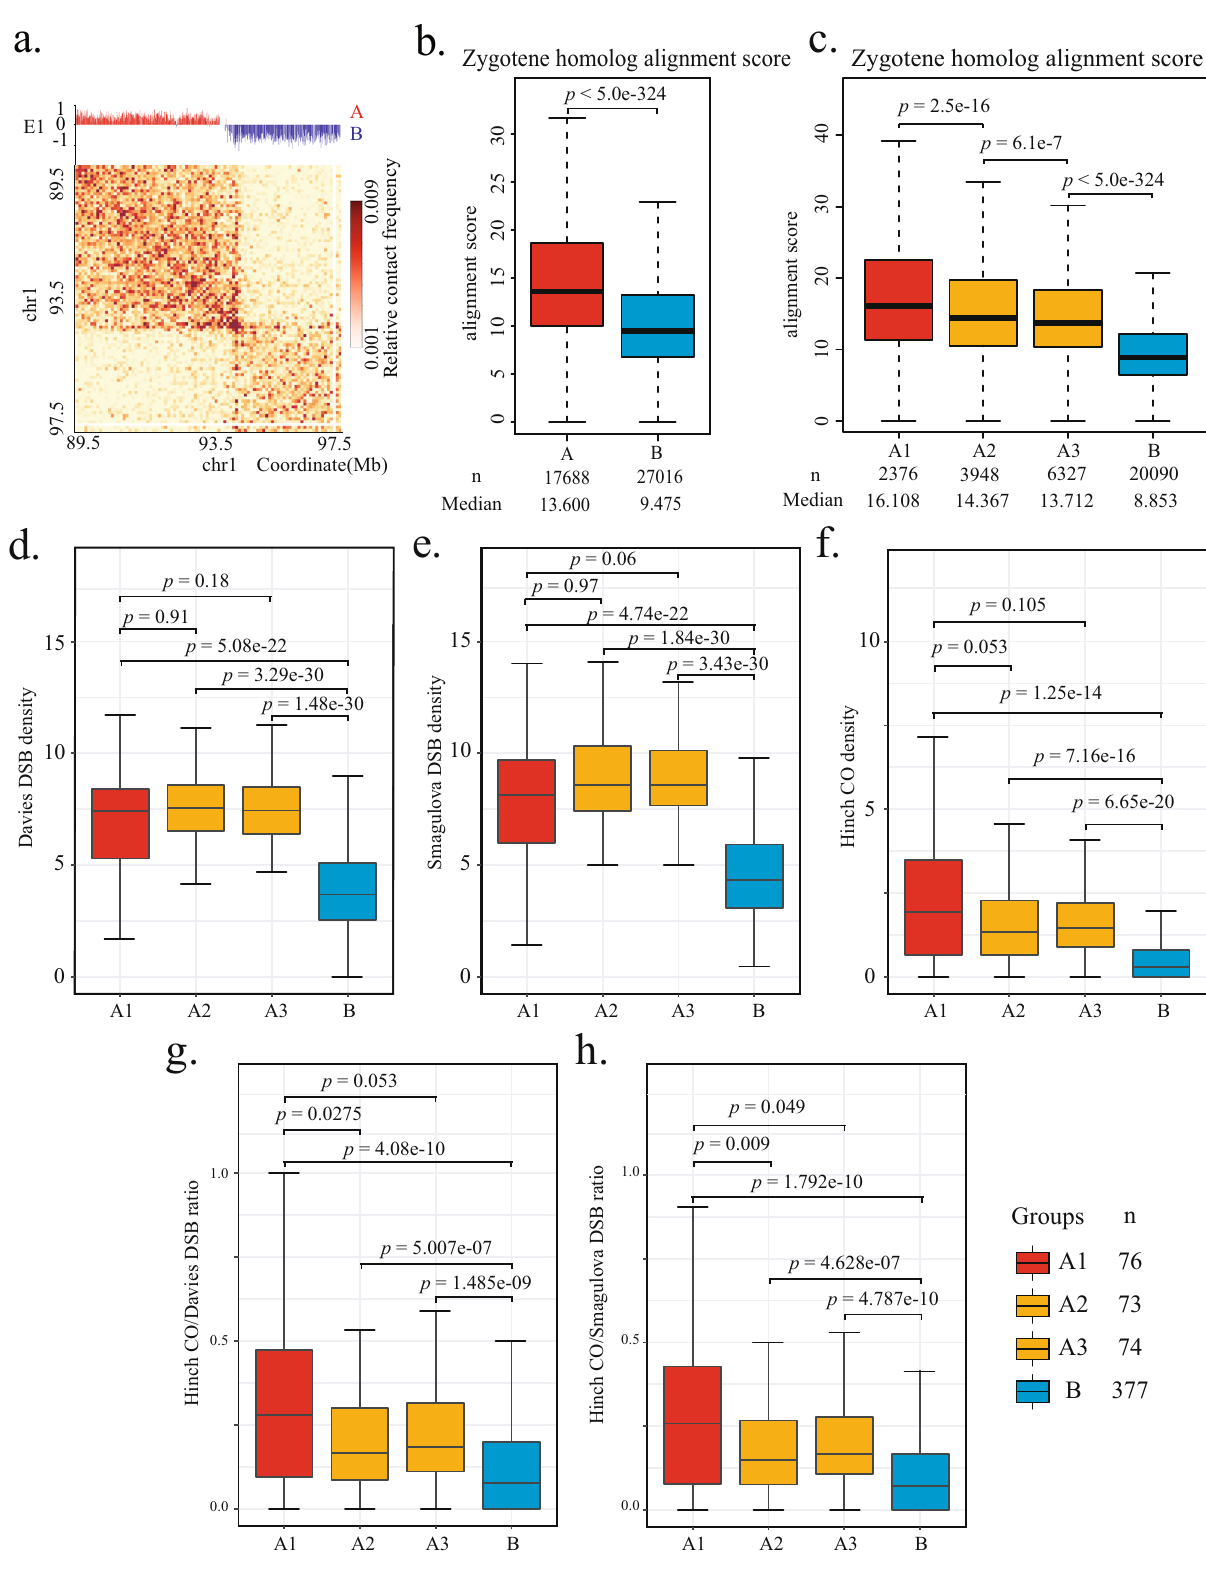
chromatin interaction frequency at 500 kb genomic separation, which serves as an indicator for the enrichment of shorter chromatin loops. Importantly, the genomic intervals within the A1 group regions, which show the greatest enrichment of short chromatin loops, also exhibited the highest alignment scores (Fig. 5c).